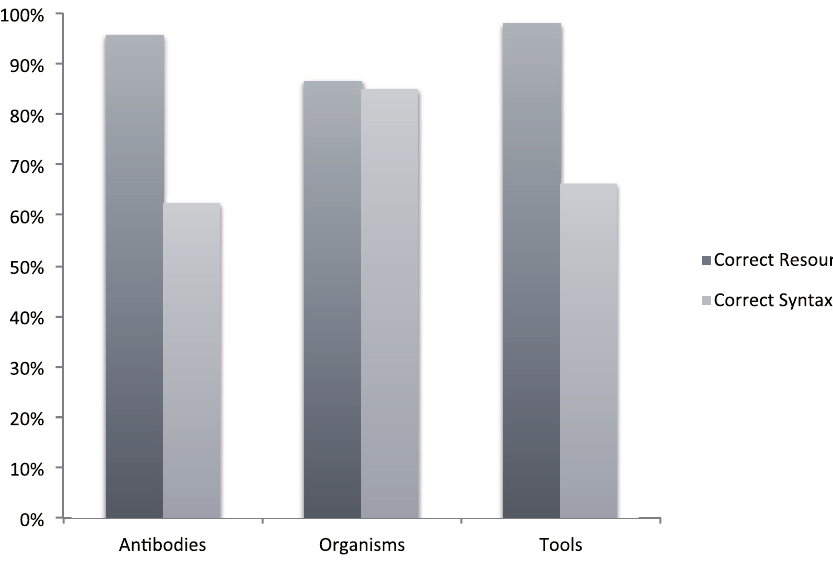
Figure 3. Percent correctly reported RRIDs. The percentage of resources that reported an RRID that pointed to the correct resource and with the correct syntax for each resource type is shown. The total number of resources for each type during the post-pilot is: primary antibodies, n = 429; organisms, n = 55; non-commercial tools, n =